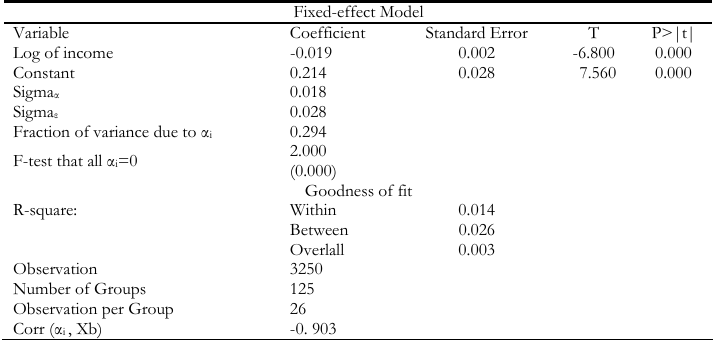
Convergence of per capita income in the 125 European regions (1977-2002) Estimation of the fixed-effect ModelEquation (2) (numbers into brackets refer to the